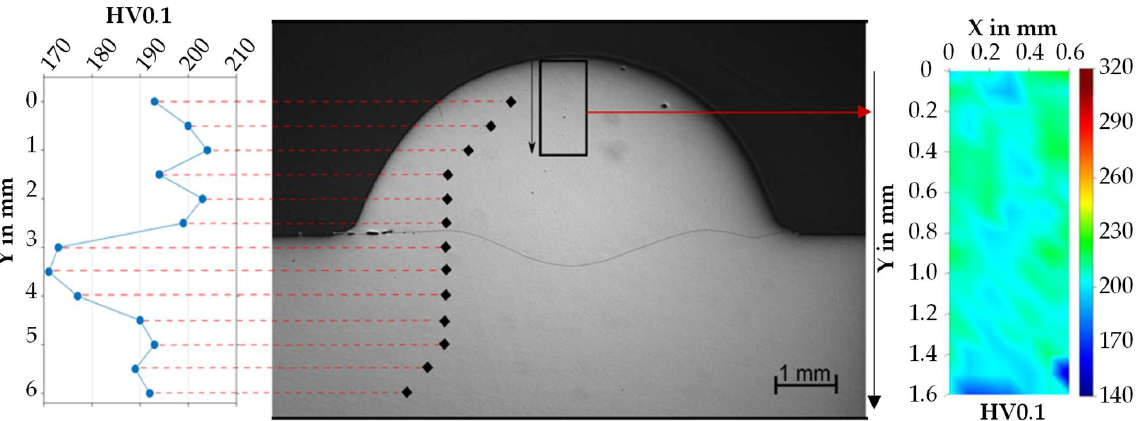
Figure 9. Cross-section and result of the hardness measurement of the sample conventional P2 (P2, I1 = 220 A). I1 = 220 A).